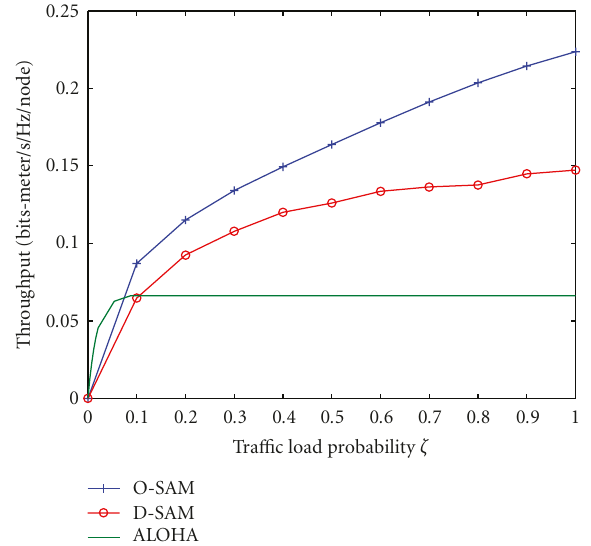
Figure 6: Throughput comparison of O-SAM, D-SAM, and ALOHA. We used ρ = 1, SNR = 40 dB, square topology, and SISO channels.